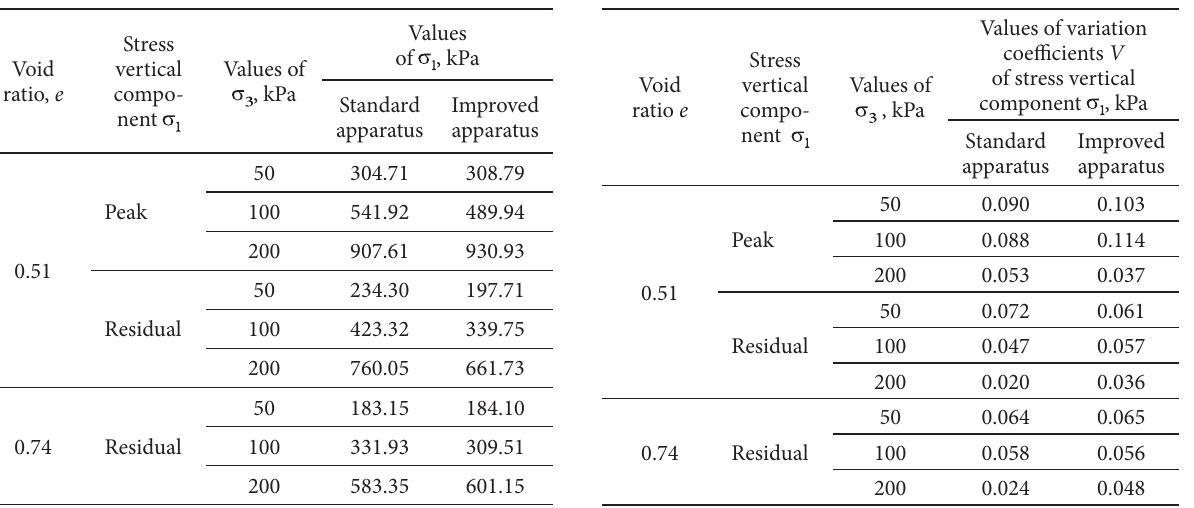
Table 1. Mean values of stress vertical component Table 2. Variation coefficients of stress vertical